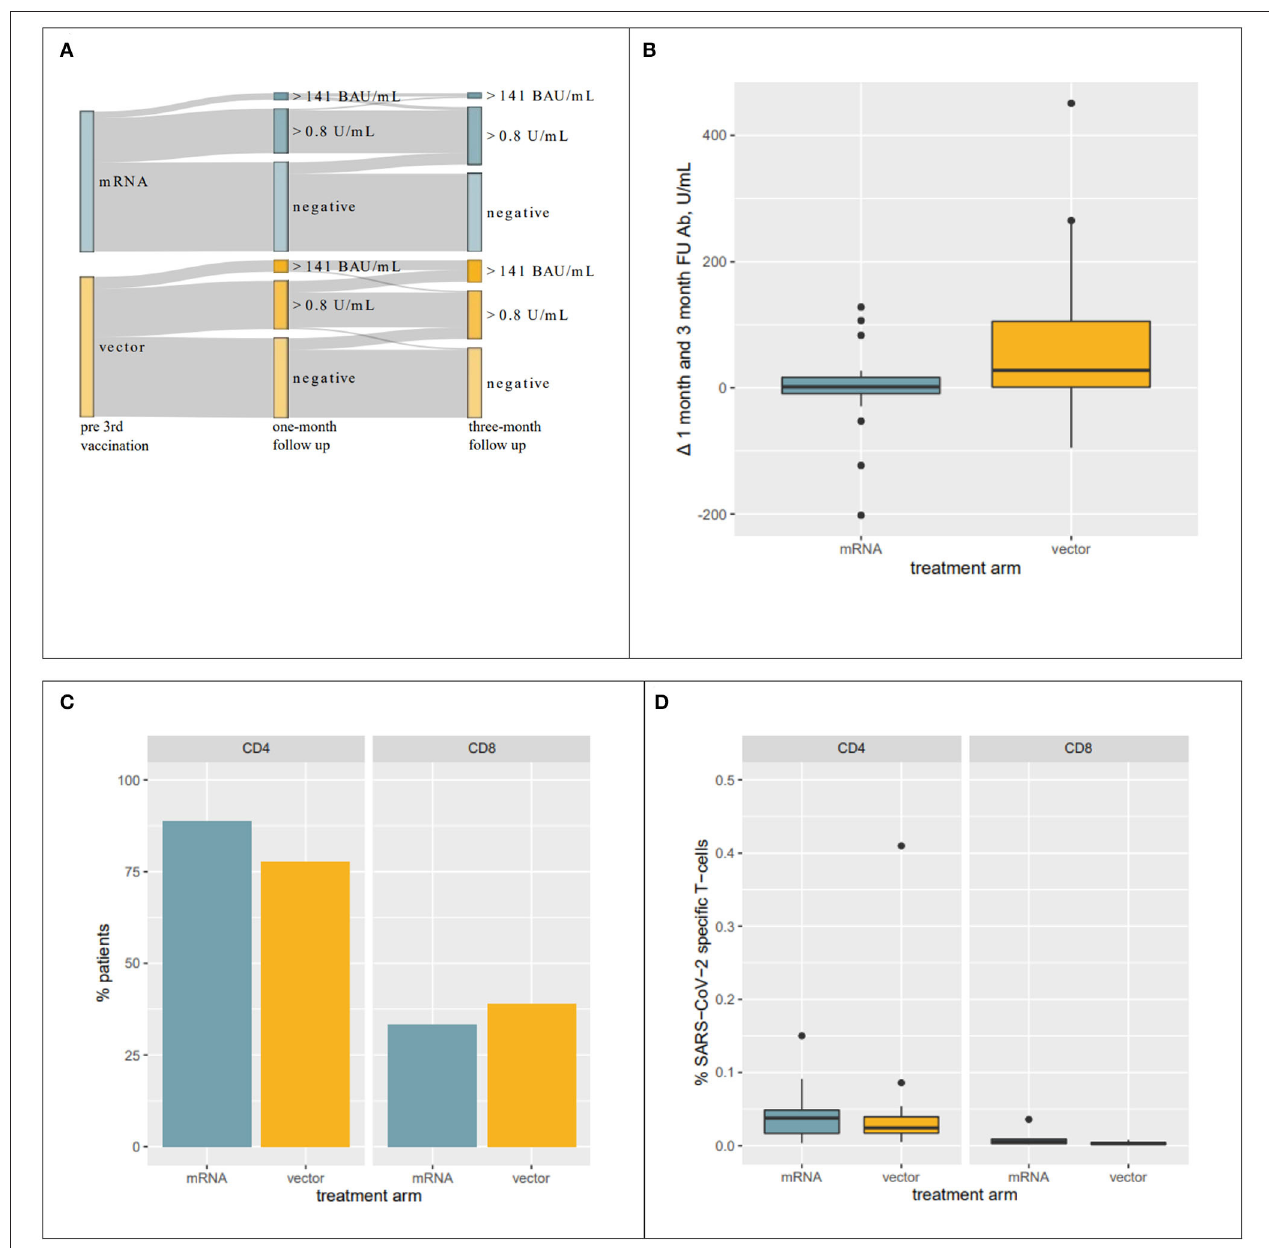
FIGURE 3 | Response to vaccination. (A) Sankey Diagram visualizing changes in the response rate to 3 rd vaccination. A significantly larger proportion of individuals developed antibody levels > 141 BAU/ml. (B) Boxplots visualizing changes in antibody levels from 1- to 3-month FU in patients who seroconverted within 1 month after receiving their 3 rd vaccination. Antibody levels in individuals receiving a heterologous 3 rd vaccination further increased while remaining unaltered in patients receiving mRNA vaccines. (C) Percentage of patients with SARS-CoV-2-specific CD4 and CD8 T-cells among the top humoral responders at the 1-month FU. (D) Percentages of SARS-CoV-2-specific T-cells in patients with SARS-CoV-2-specific CD4 and CD8